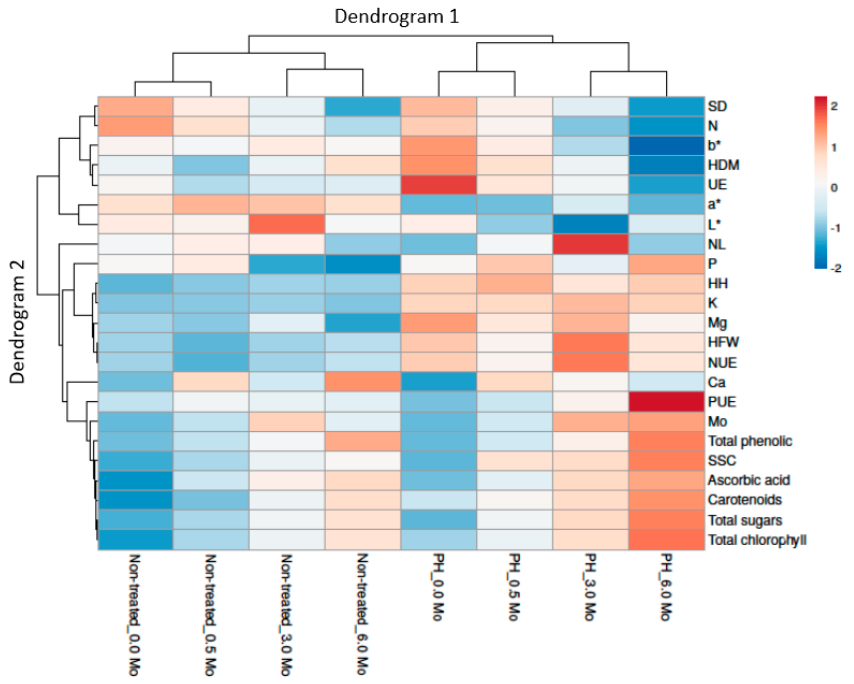
Figure 6. Heat map analysis including all ‘Canasta’ lettuce plant traits in response of PHs and Mo treatments. The heat map figure was created using the https://biit.cs.ut.ee/clustvis/online program (accessed on 15 January, 2021) package.